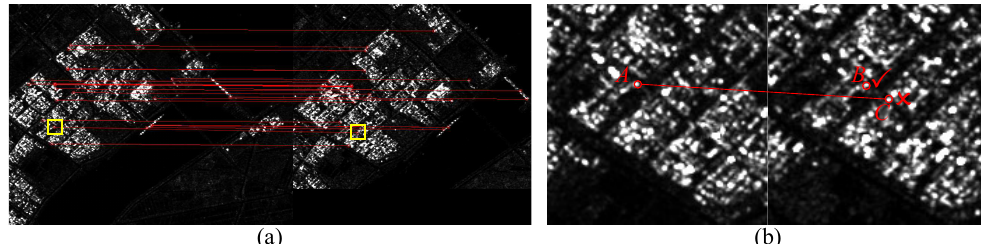
Figure 2. Illustration of a mismatched point pair. ( a ) Registration results obtained by Sim-CSPNet [20]. ( b ) Enlarged regions of the mismatched point